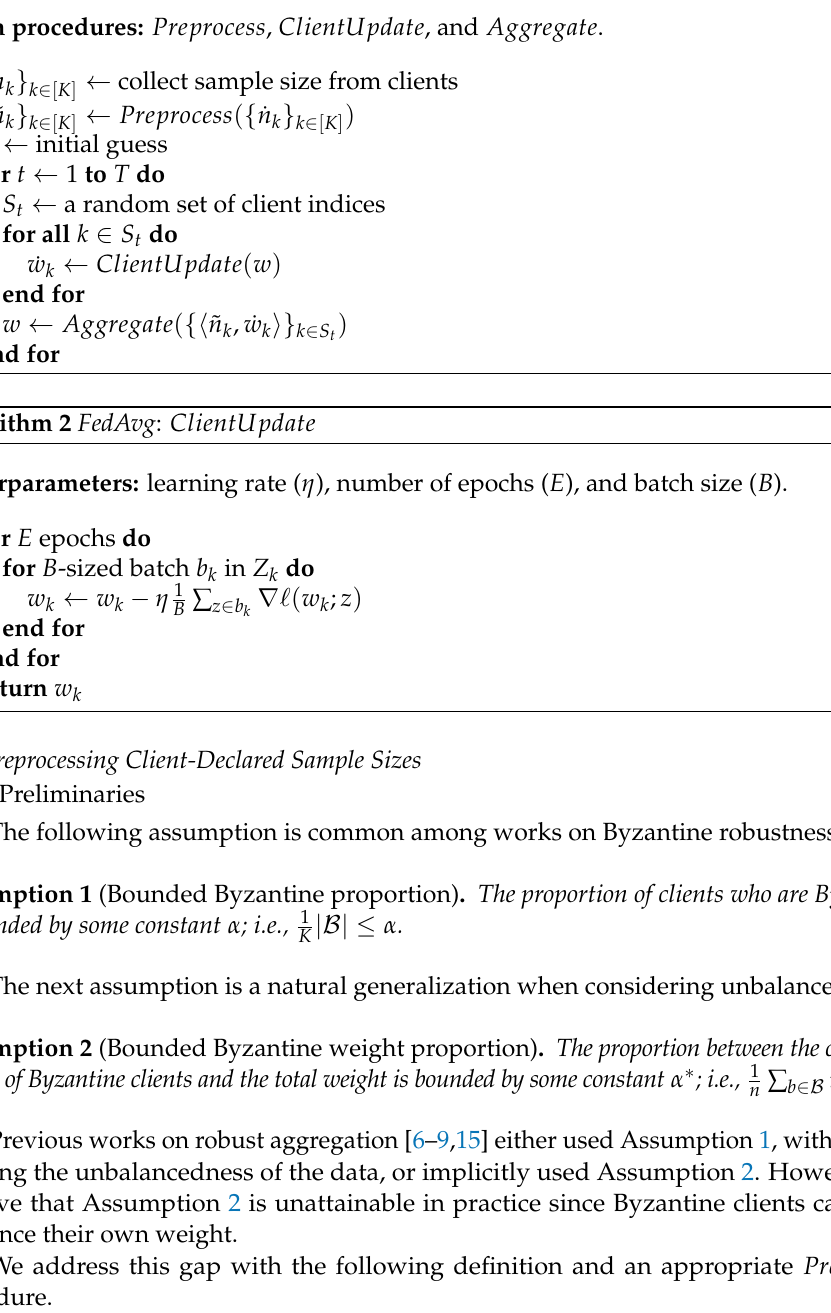
Algorithm 1 Federated Learning